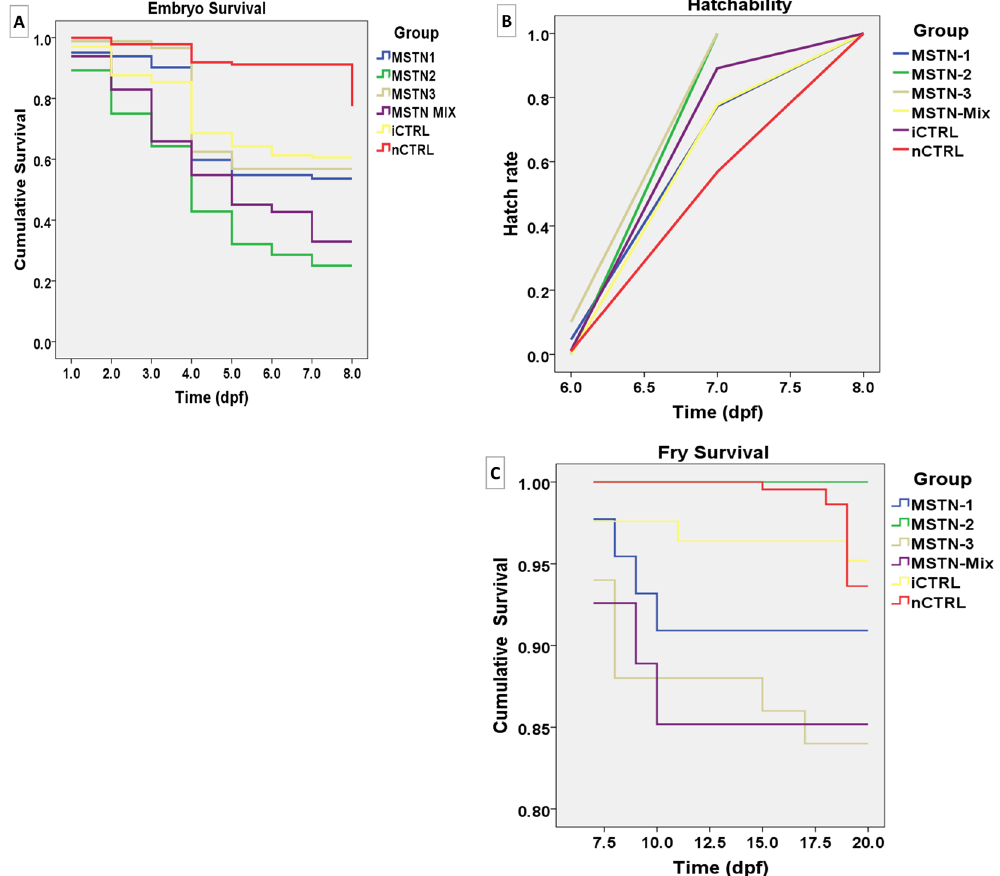
Figure 2. Plots of ( A ) embryo survival, ( B ) mean time to hatch, and ( C ) fry survival; embryos microinjected at the one-cell stage with sgRNAs/Cas9 protein targeting the channel catfish MSTN gene. Three sgRNAs were microinjected individually (MSTN-1, MSTN-2 and MSTN-3) and multiplexed (MSTN-Mix). Two controls were used; Injected control embryos (iCTRL) were full-siblings to the treatment groups and were injected with the same solution and volume but without sgRNA or Cas9 protein. The second control was not injected (nCTRL). Hatch rate was calculated as the number of embryos that hatched at a given time-point (day post- fertilization, dpf) compared to the total number of embryos that